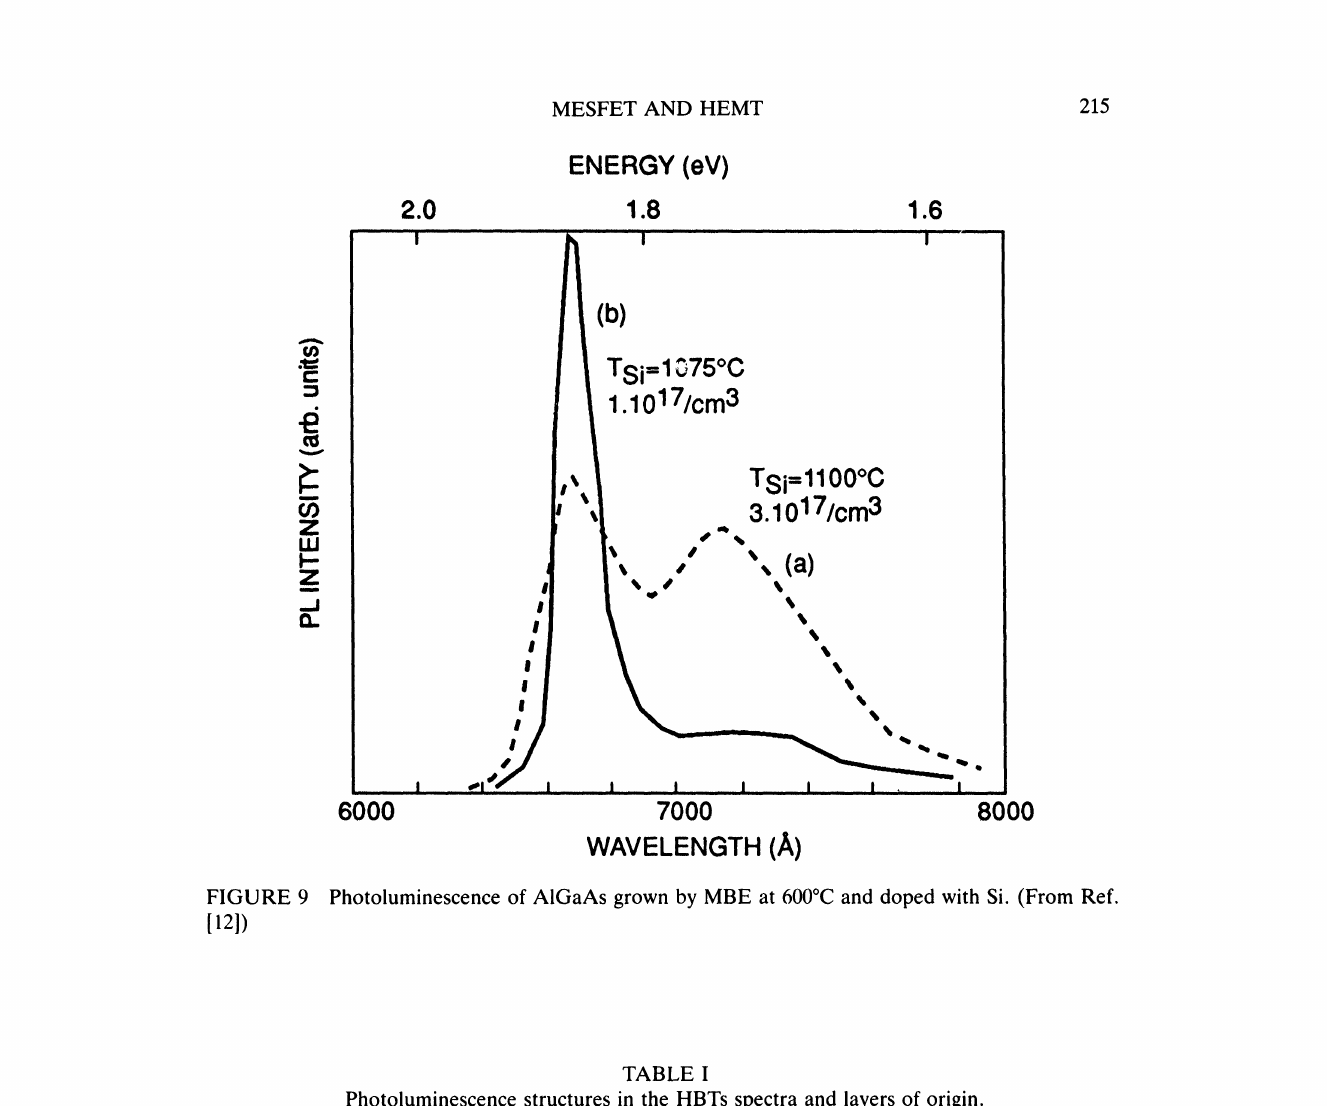
Photoluminescence structures in the HBTs spectra and layers of